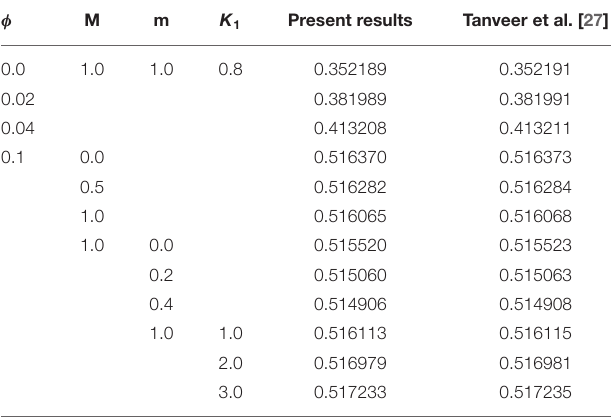
TABLE 2 | Comparison of results for − κ eff /κ f θ ′ (0) with Tanveer et al. [27] when α = α 2 = E 4 = E 5 = ε 1 = Gr = R =